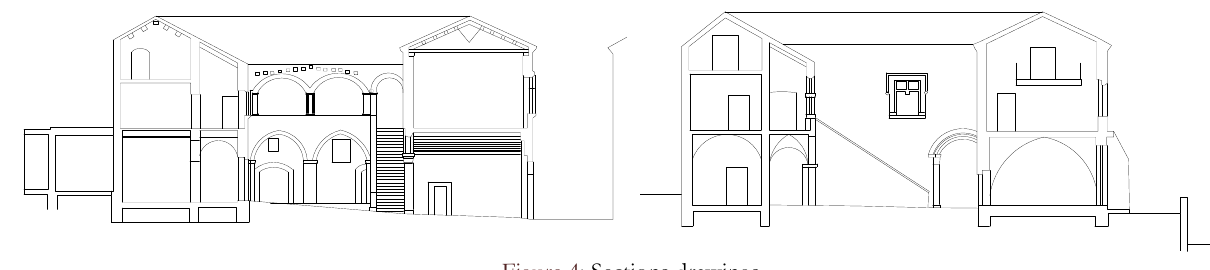
Figure 2: Ground floor plan. Figure 3: Elevation.